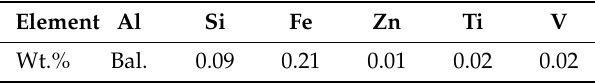
Table 1. Chemical composition of the 1050